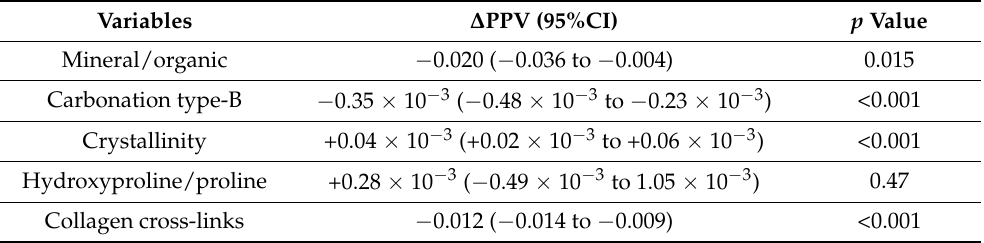
Table 2. Physicochemical variables evaluated over the 12 months of burial time across the 6 subjects and the 2 ribs. The slope estimated by the linear mixed model is the averaged variation in PPV per month over 12 months ( ∆